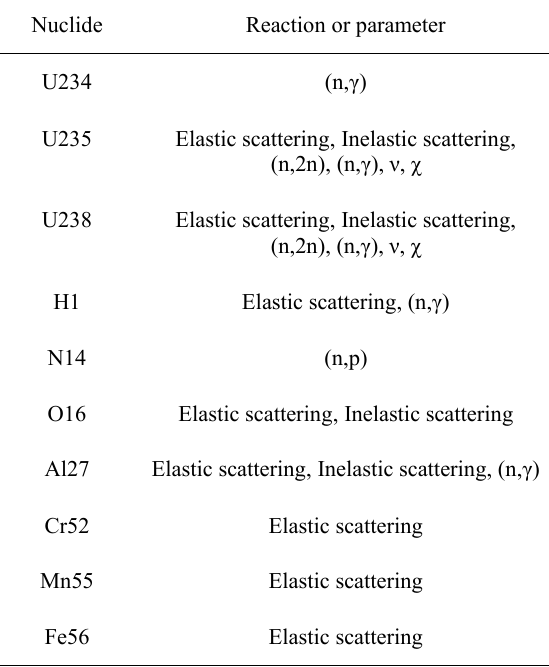
Table 1. Target nuclides for the cross-section adjustment